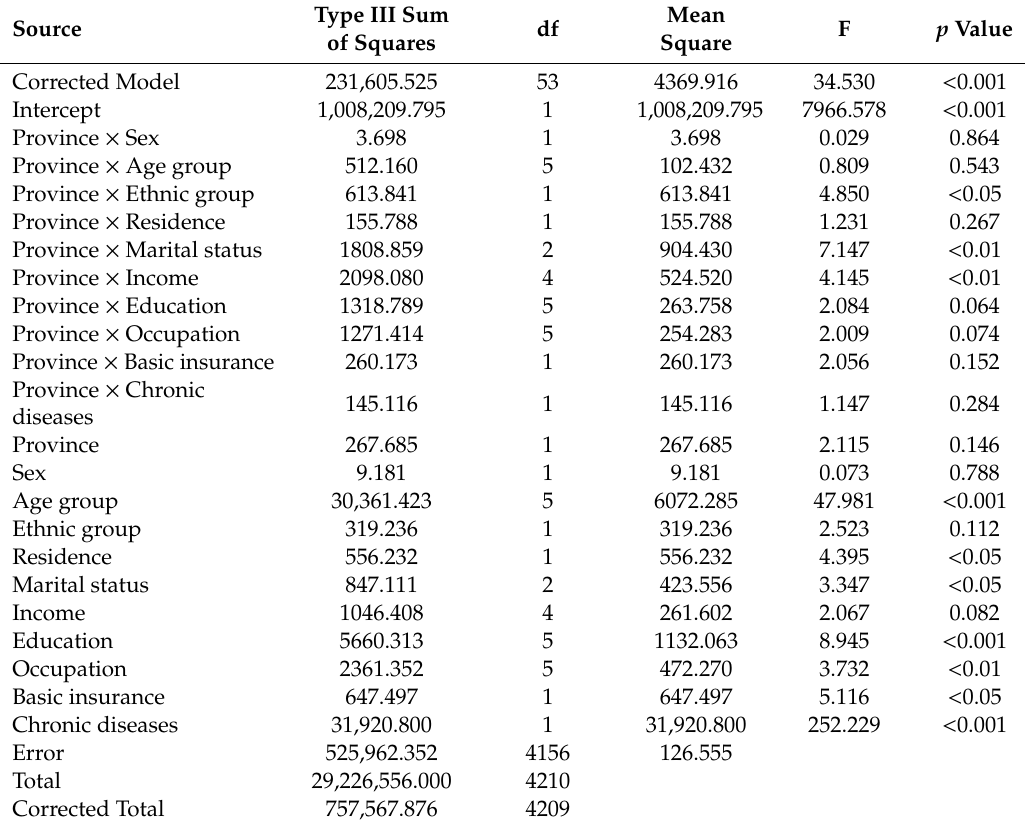
Table 5. ANOVA on the influencing factors and interacting factors. Dependent variable: VAS